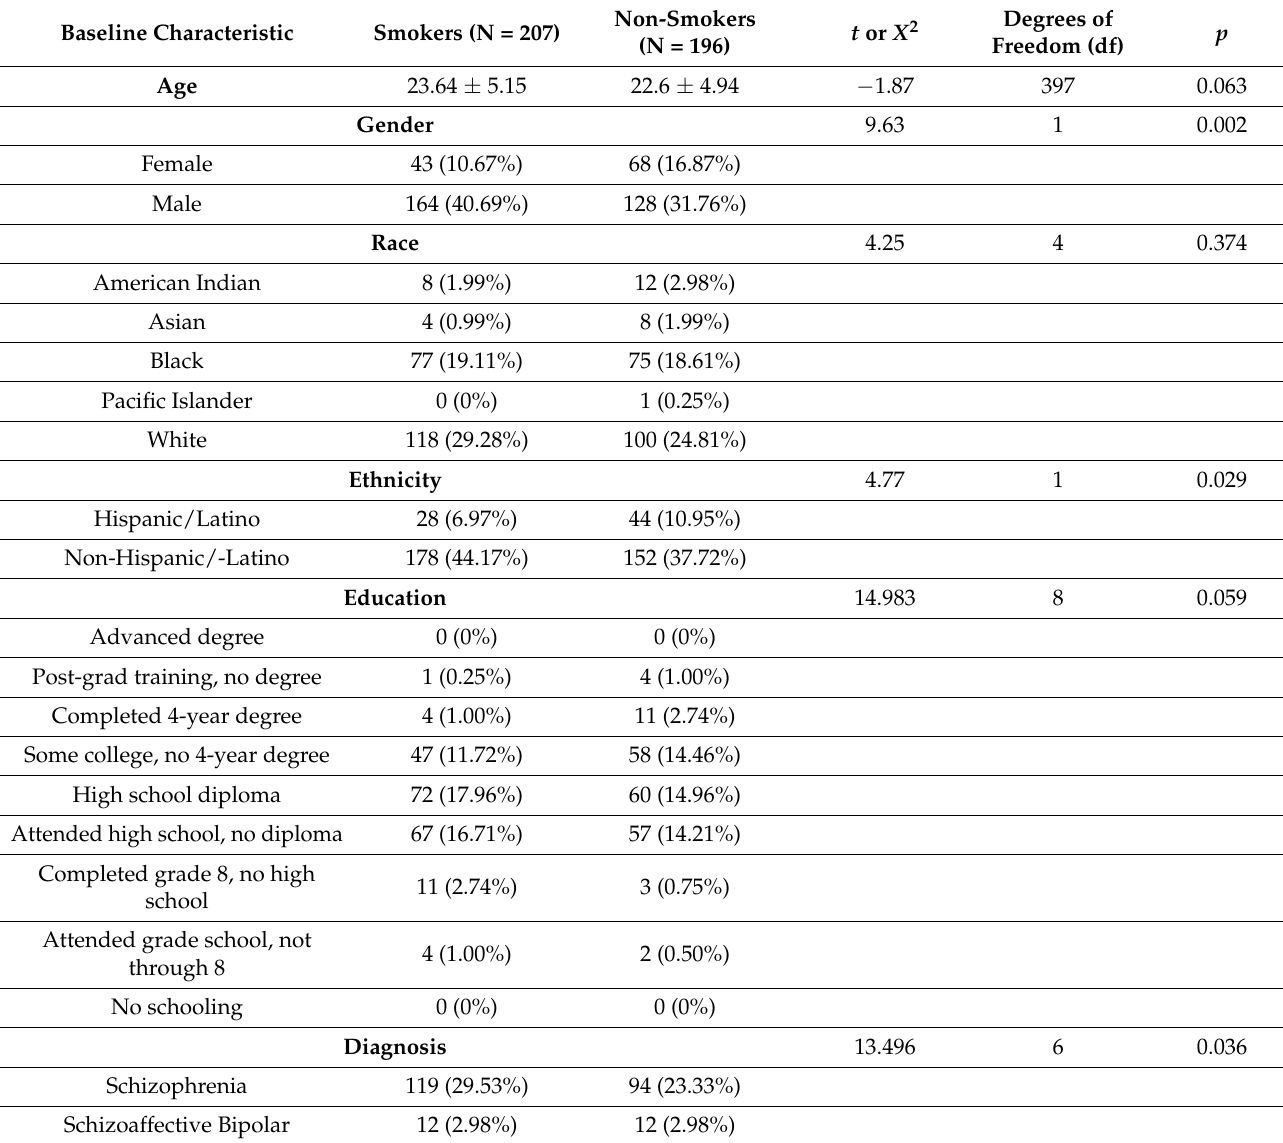
Table 1. Demographic and clinical characteristics of smoking and non-smoking participants at baseline. Data are reported as frequencies (with approximate percentages) or means ± standard